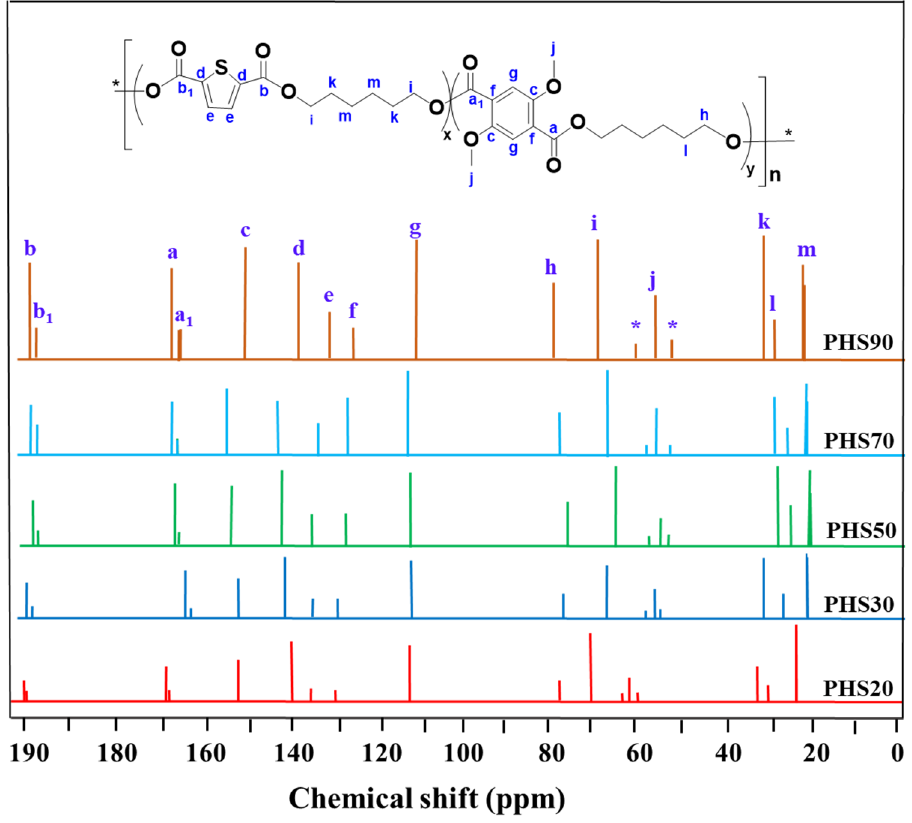
Figure 5. 13 C NMR spectrum for copolyester PHS(20–90). * : polymer end-chains signals. Table 4. Thermal analysis results for copolyesters